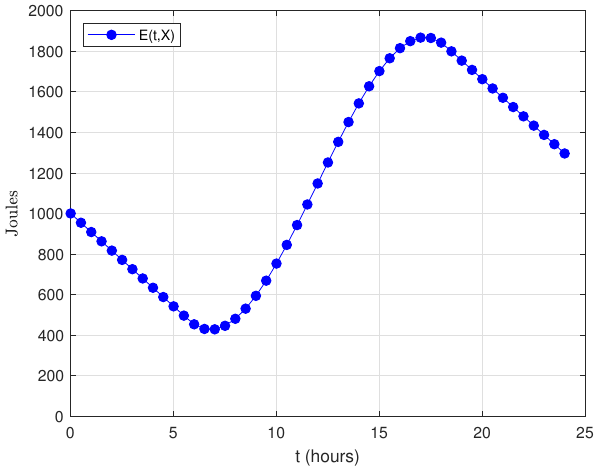
Figure 16. Evolution of E ( t , X ) during a one-day period, for DC =